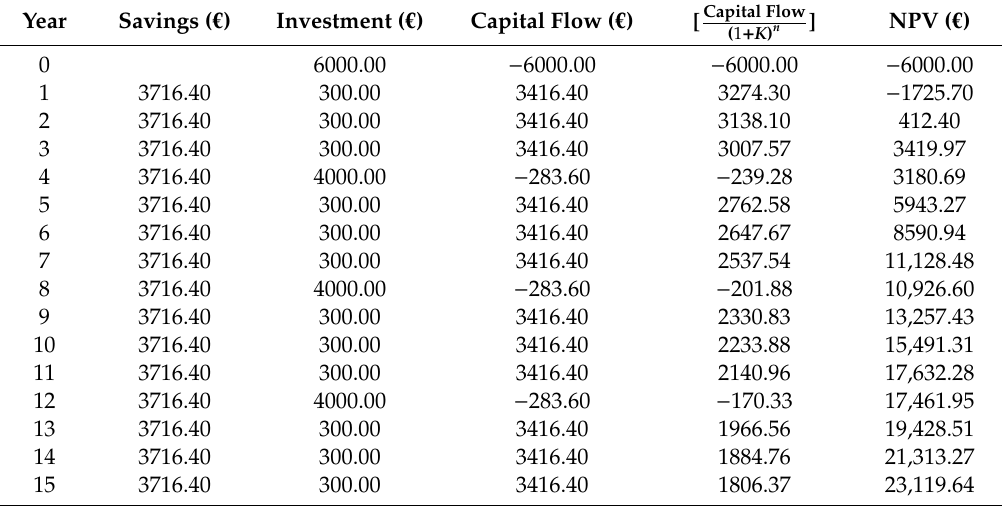
Table 4. Net Present Value (NPV) per